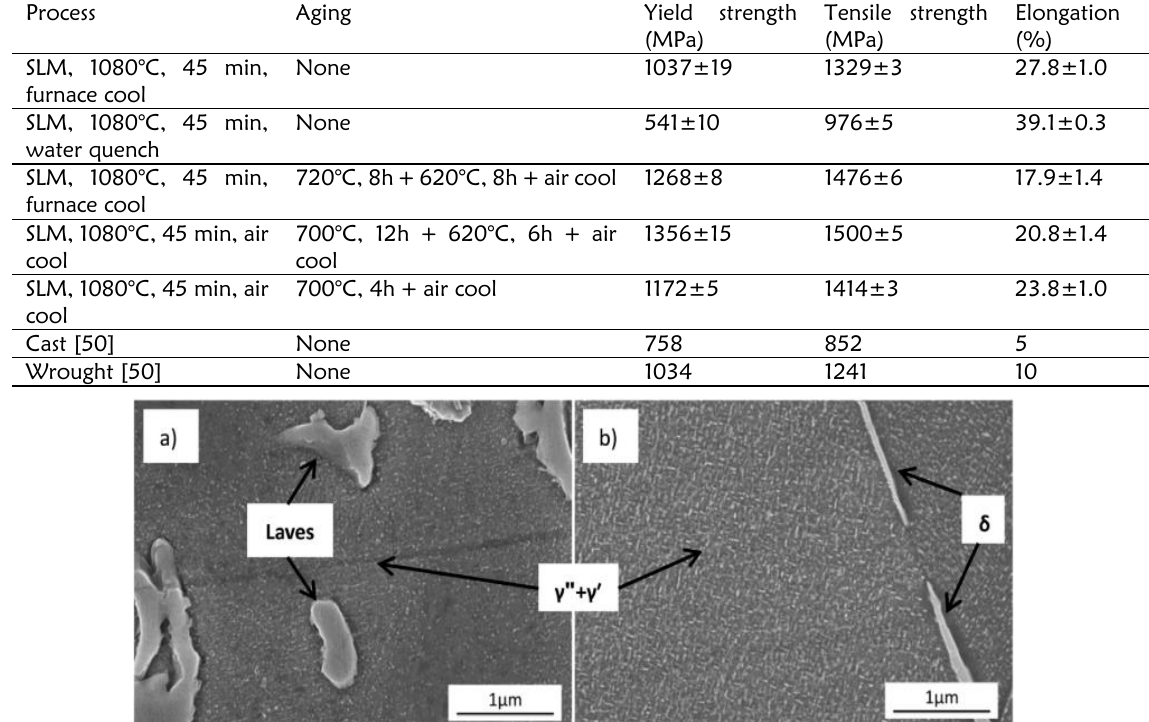
Table 5. Effect of solution heat treatment and aging on mechanical properties of SLM IN718 [48].